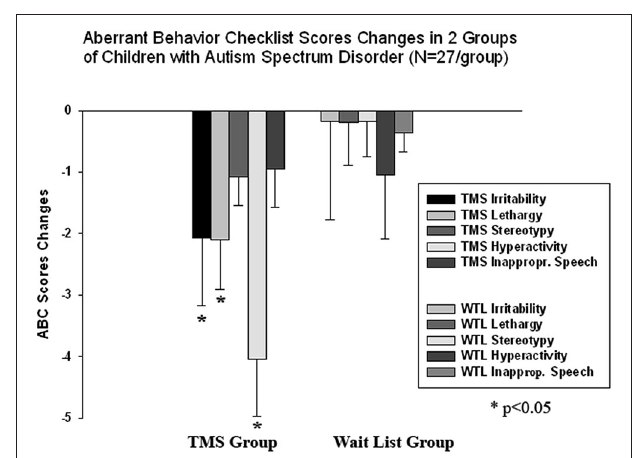
FIGURE 8 | Changes of Repetitive Behavior Scale (RBS-R) scores post-TMS/wait-list treatment as compared to baseline levels in two 26 ) = 6.63, groups of children with ASD ( N = 27/per group). Stereotype Behavior, Ritualistic Behavior and Total RBS scores decreased significantly in the TMS group.